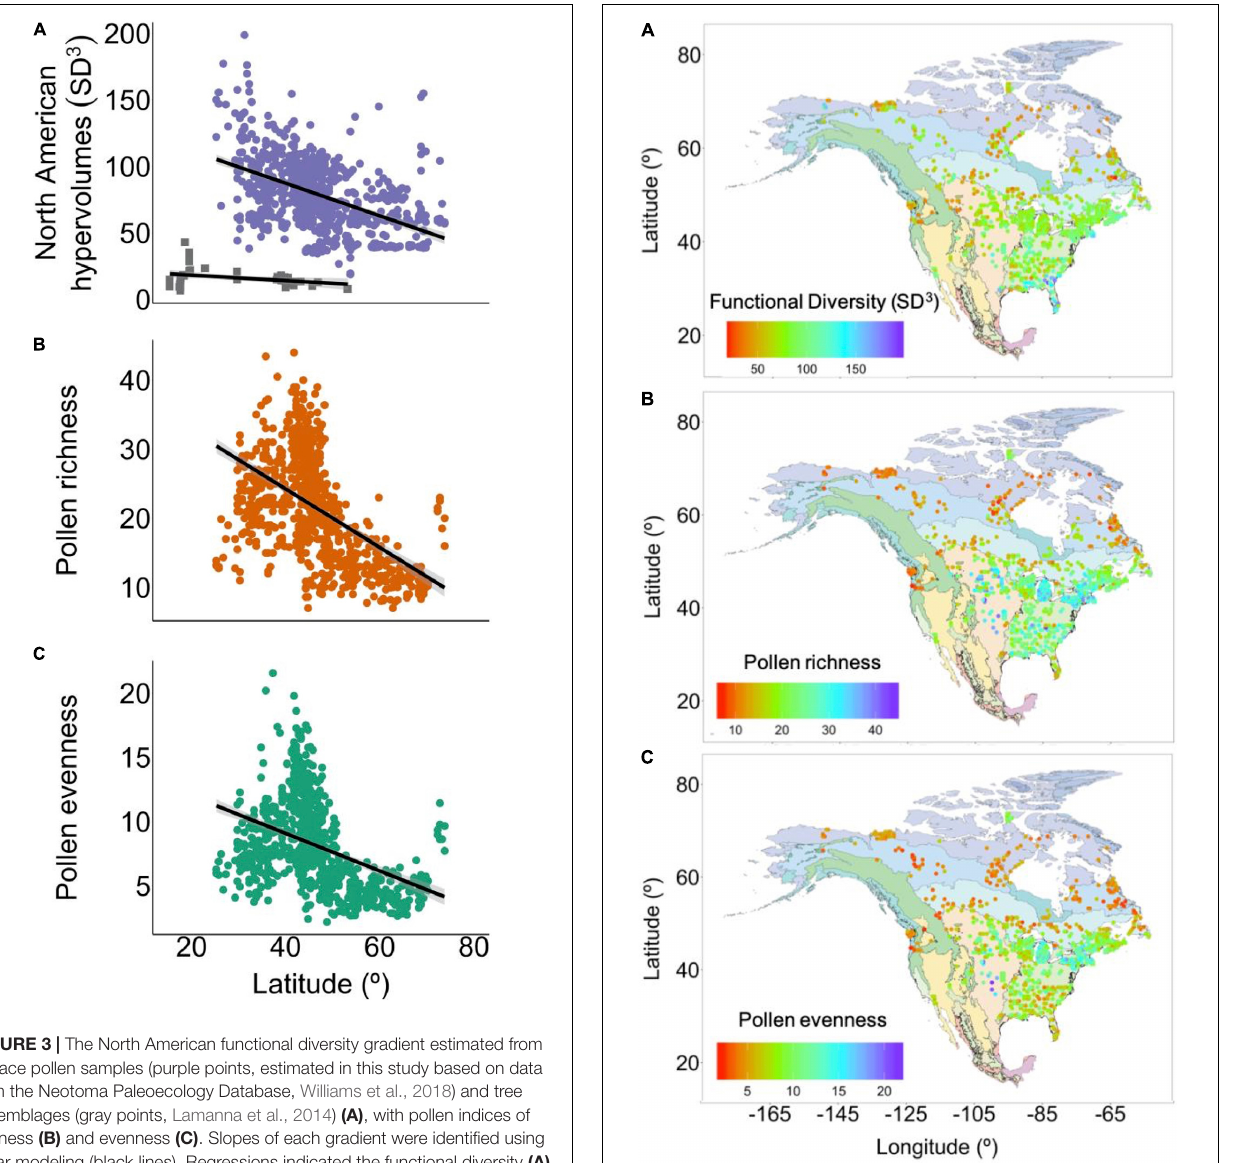
not, once spatial autocorrelation was accounted for Table 1